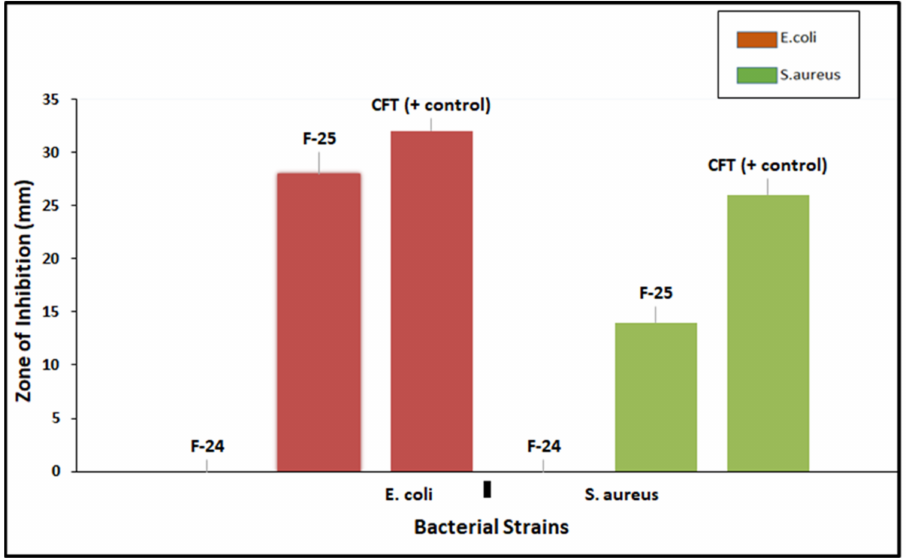
Figure 11. Graphs showing the zone of inhibition (ZOI) of optimized NPs (F-25) against E. coli and S. aureus